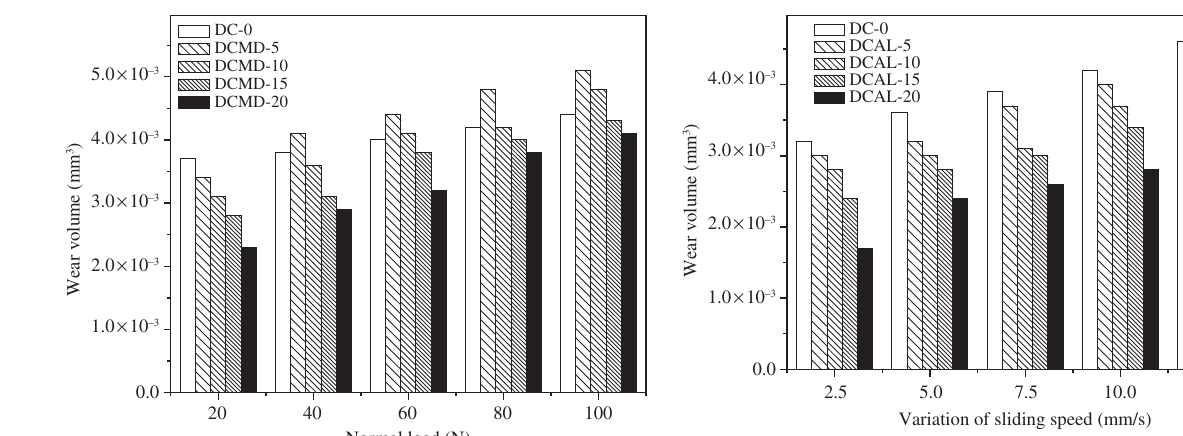
Figure 5: Effect of normal load on wear volume of the marble dust-filled dental composites.